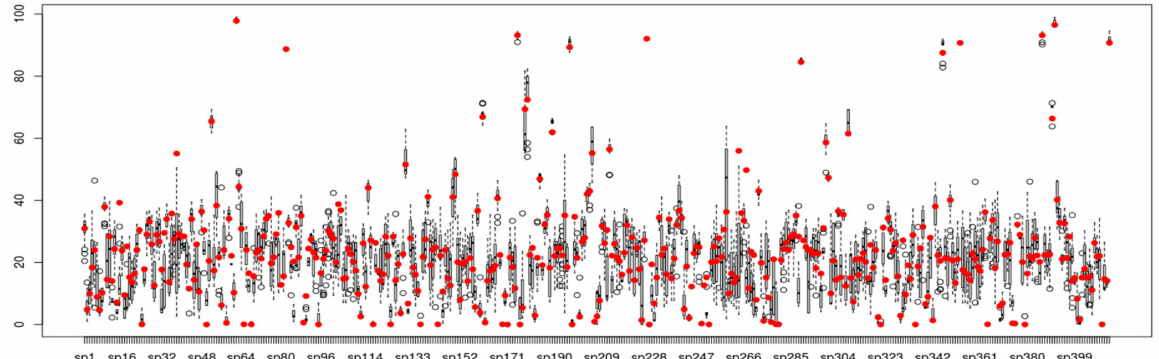
Figure A2. Percentage of predicted species range across distribution models with good predictive performance. The points represent the predicted range from the ensemble model.